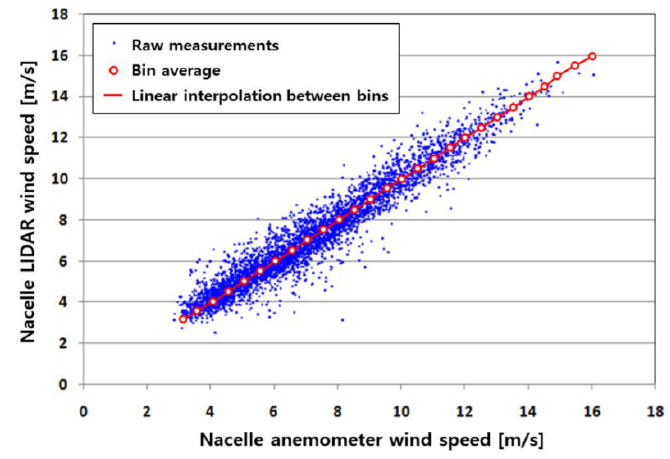
Figure 3. Relationship between the nacelle LIDAR and the nacelle anemometer wind speeds.